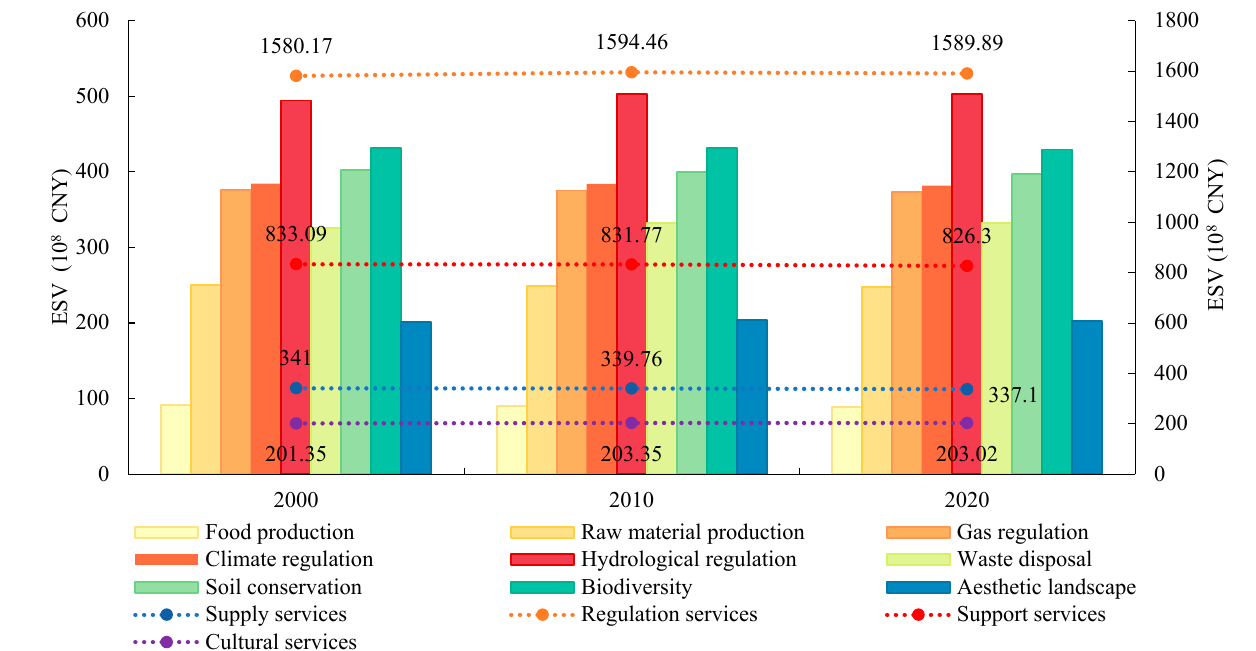
Figure 4. ESV of different ecosystem service types from 2000 to 2020.